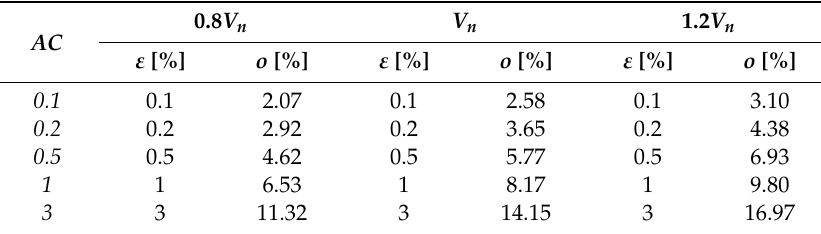
Table 5. Results for measuring purpose LPVTs.